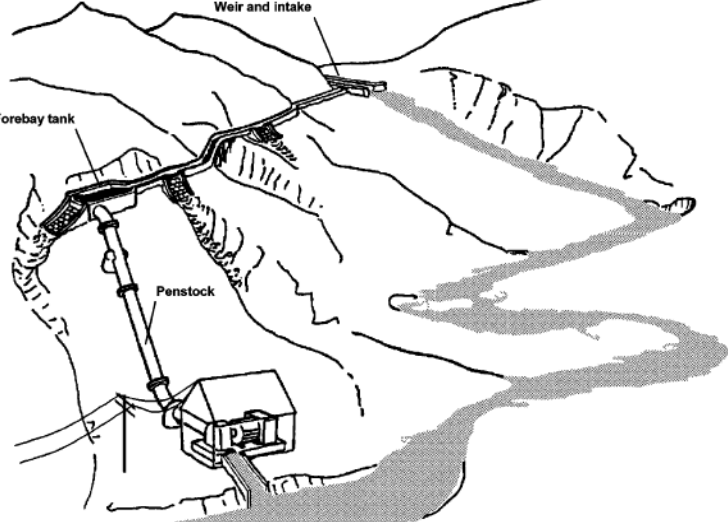
Figure 37. Schematic of a small hydro installation. © 2002 Elsevier, reproduced with permission from